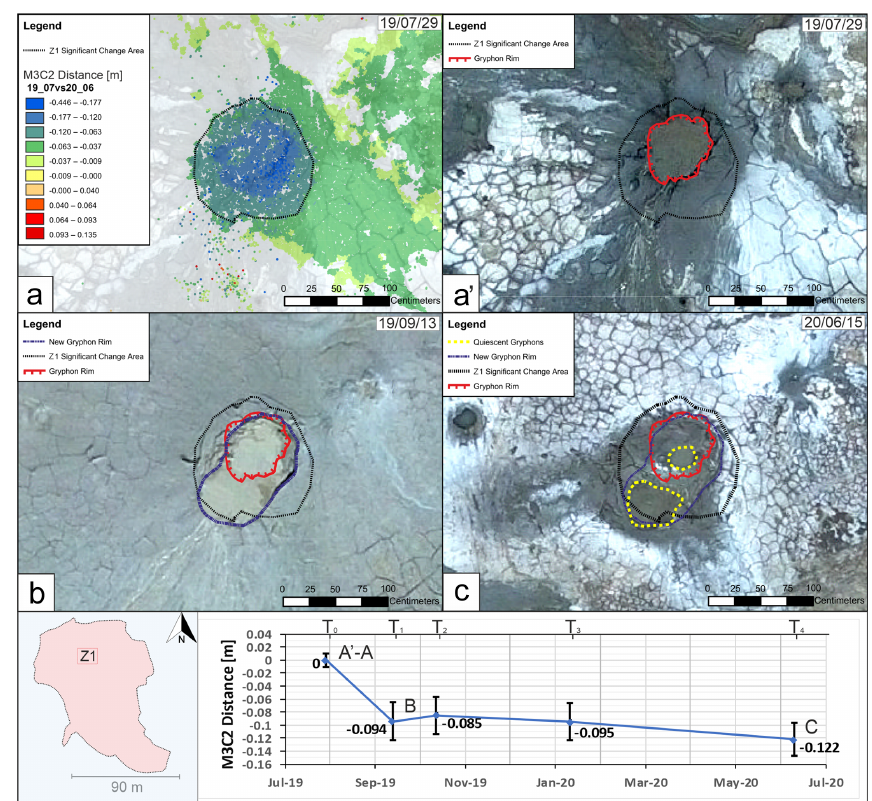
Figure 16. (a) M3C2 distance (29 July 2019 vs. 15 June 2020) of Z 1; the area used to create the time series is delimited with a dashed line (selected by significant change). (a’) Orthophoto of 29 July 2019 with the gryphon border in red. (b) The orthophoto of 13 September 2019 highlights the expansion of the gryphon border in blue. (c) Orthophotos of 15 June 2020 showing the gryphon during the quiescence phase and the split of the channel in yellow. Below, the time series with a decreasing trend is shown. The reference system is WGS 84/UTM zone